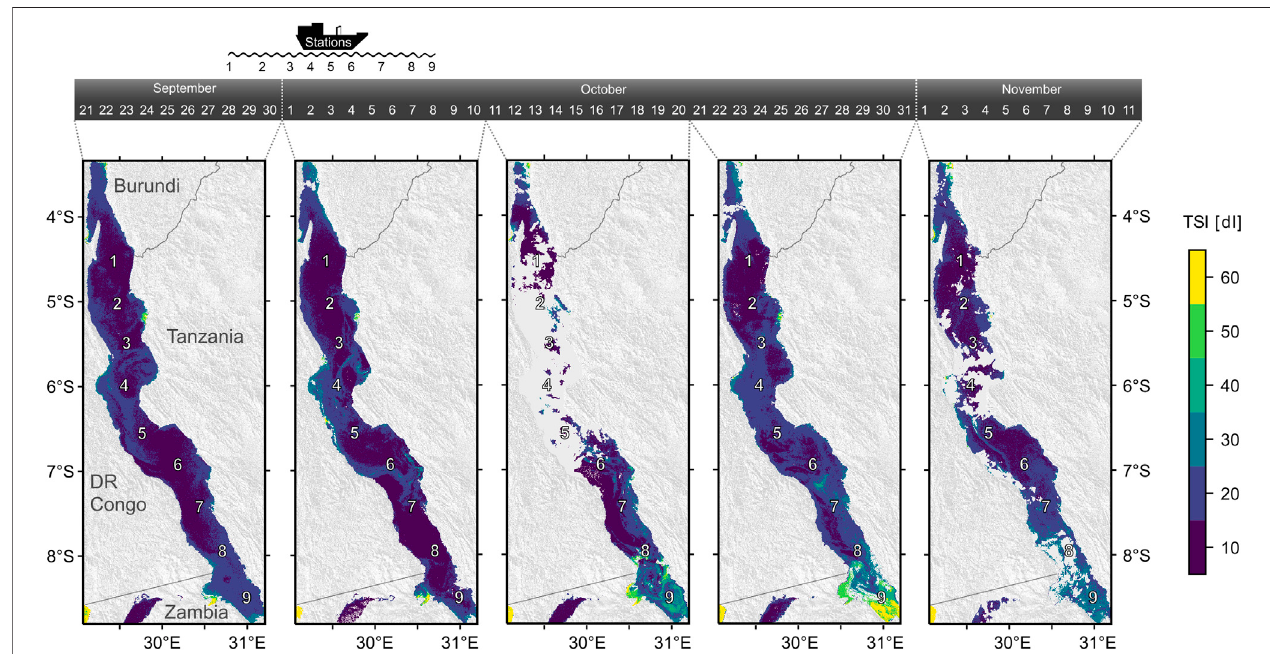
FIGURE10| Trophicstateindex(TSI)basedonSentinelsatellitedatashowingtheevolutionanddecayofthesurfacebloominthesouthofLakeTanganyikaduring and after the sampling campaign in 2017. The maps are calculated as averages from 2-4 single images created within the indicated time intervals. The duration of the cruise is shown on top. Numbers indicate the sampling